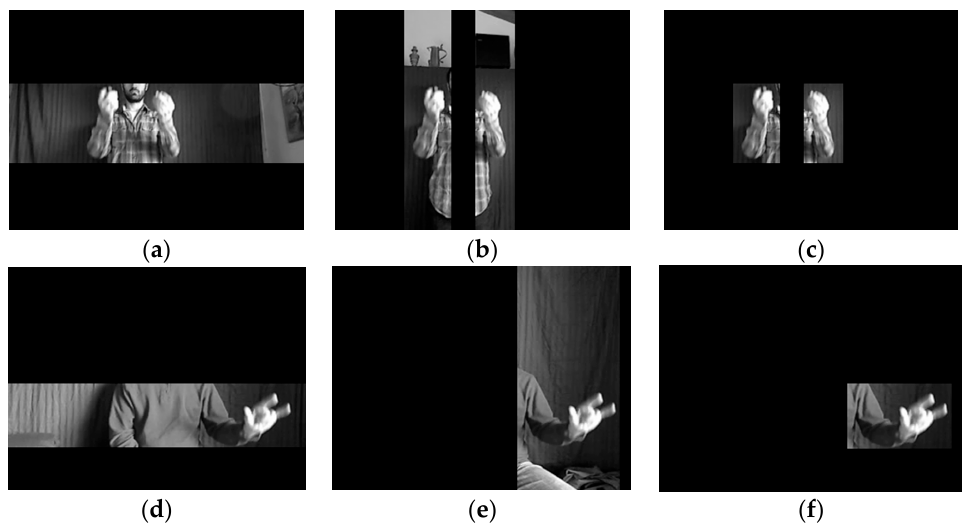
Figure 4. Extracted horizontal, vertical and final MRoIs. ( a – c ) The MRoIs of two moving hands frame; ( d – f ) The MRoIs of single moving hands frame. (a,d) The horizontal MRoIs; (b,e) The vertical MRoIs; (c,f) The final MRoIs.